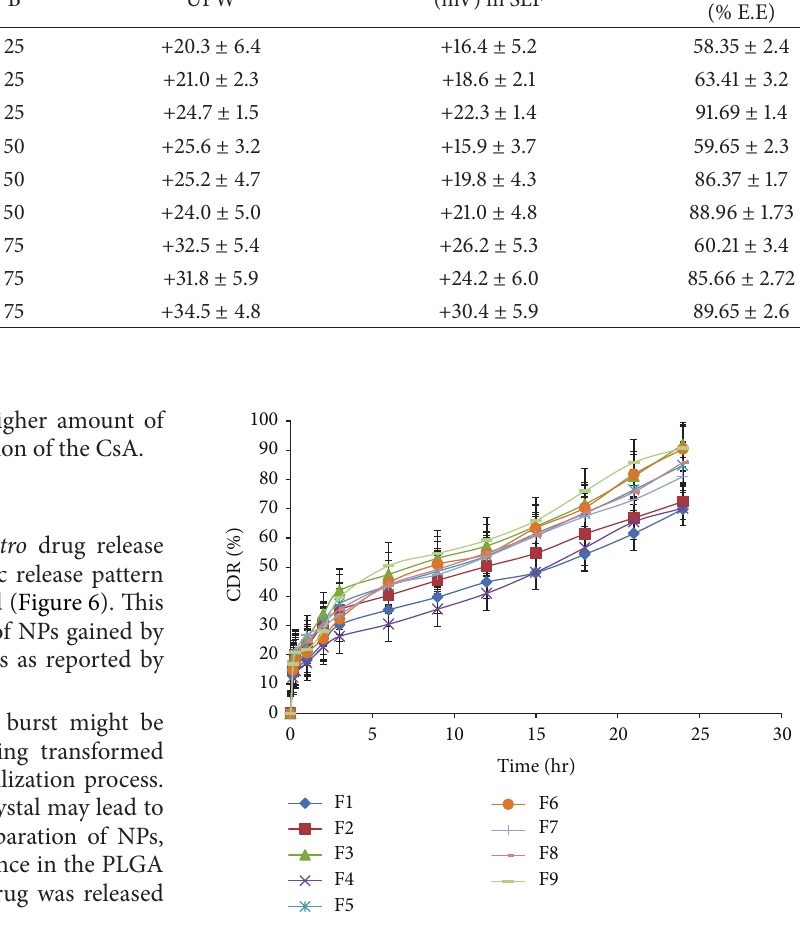
Figure 6: In vitro drug release study of CsA loaded NPs.